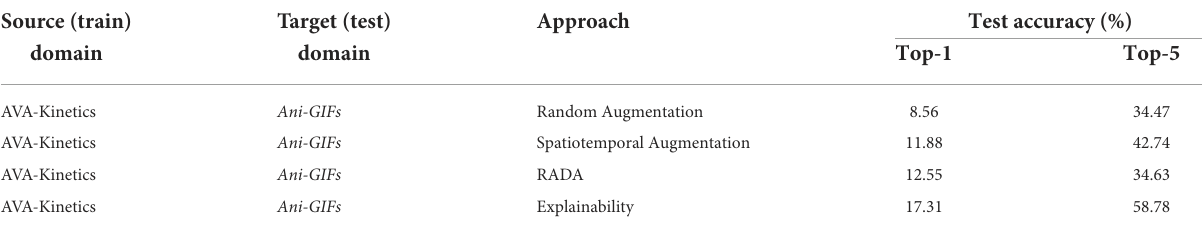
TABLE 3 Study 2 results. Top-1 and top-5 test accuracies of our baseline algorithms are given, from fine tuning on 12 classes of the AVA-Kinetics dataset, on the Ani-GIFs dataset, the testing domain. Source